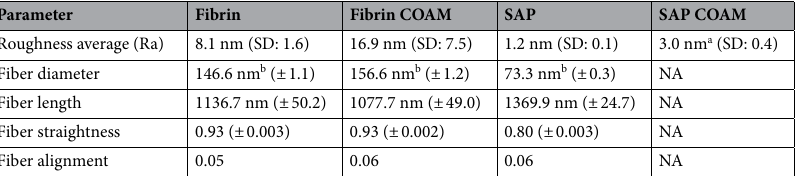
Table 1. AFM image analysis using ctFIRE fiber extraction algorithm. SD Standard deviation. ± Standard Error of Mean. a Measured on the aggregated fibers. b Approximately overestimated by 15 nm because of tip diameter. NA not available because fiber aggregation rendered measurements